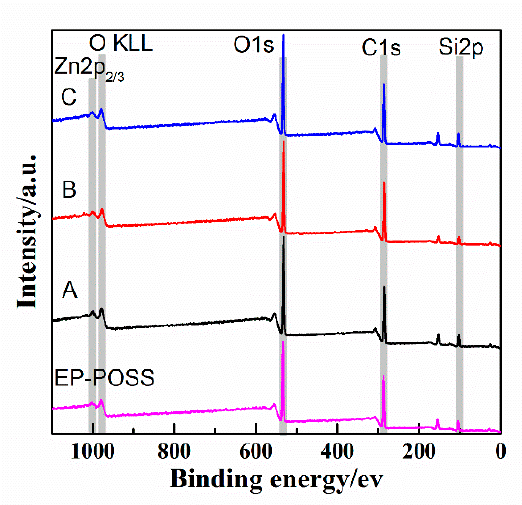
Figure 7. XPS spectrum of EP-POSS film with inorganic nanoparticles. A—EP-POSS/SiO 2 /graphene, B—EP-POSS/ZnO/graphene, C—EP-POSS/graphene.